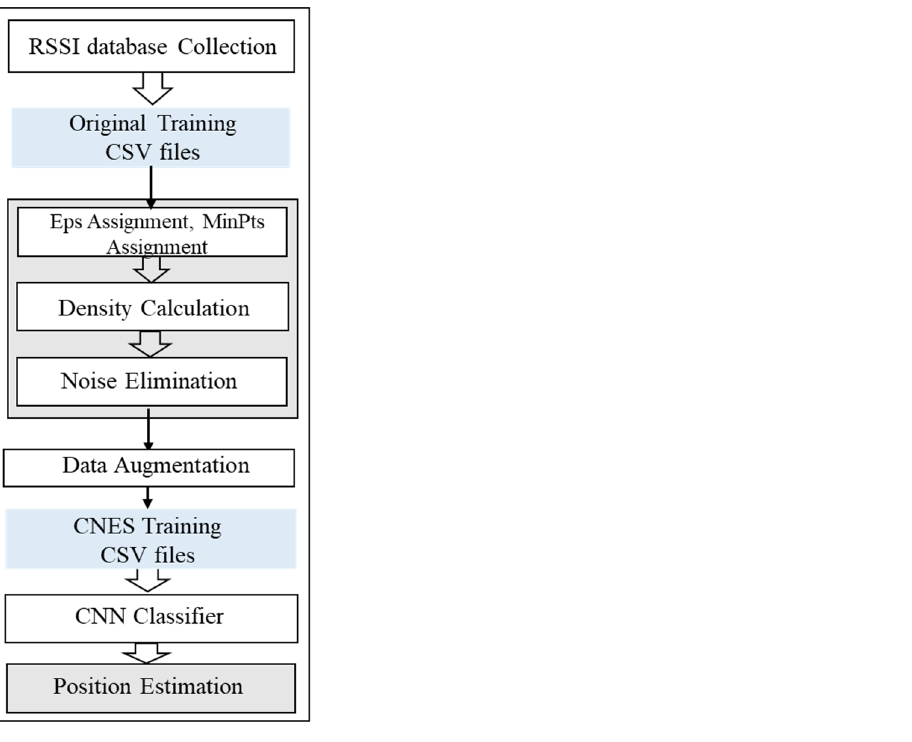
Figure 10. Flow graph for clustering-based noise elimination and position estimation .